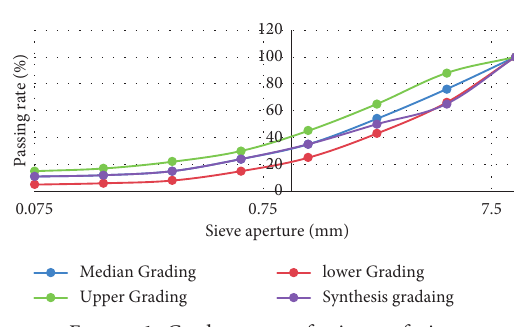
Figure 1: Grade curves of microsurfacing. Table 2: Technical specifications of modified emulsified asphalt.